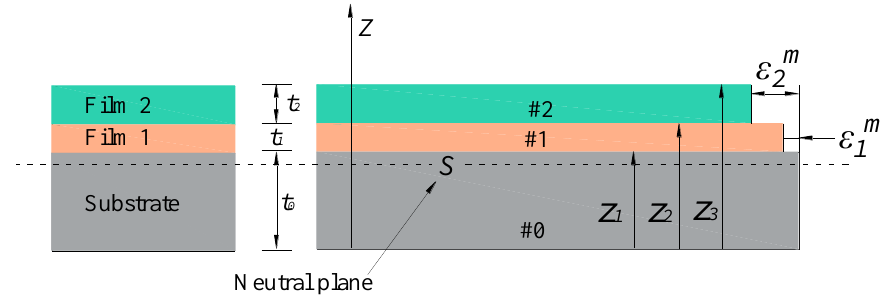
Figure 3. Structural parameters and mismatch strain of double-layer film system on 304SS substrate. t is the thickness of the film, s is a neutral layer